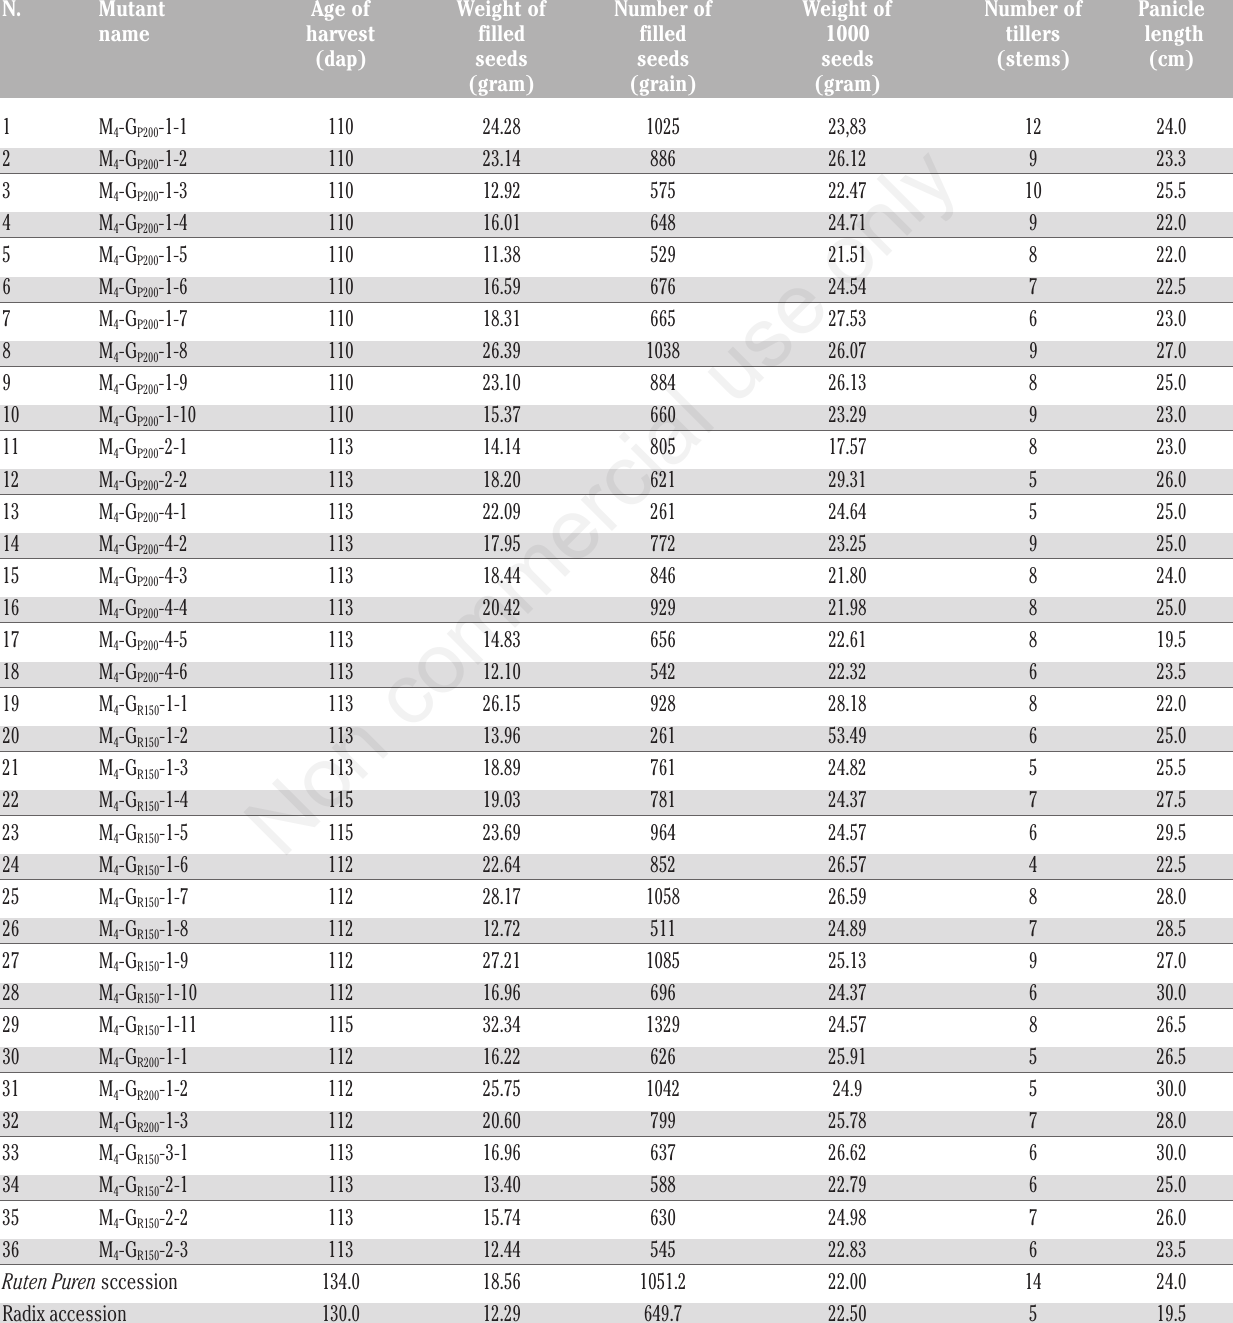
Table 1. The selected M4 red rice paddy through pedigree selection. N. Mutant Age of Weight of Number of Weight of Number of Panicle name harvest filled filled 1000 seeds seeds